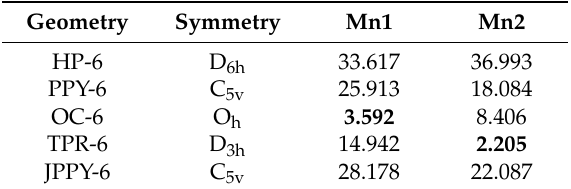
Table 2. Shape values for the five possible coordination geometries found for coordination number six in Mn1 and Mn2 in compound 1 . The minimum values are indicated in bold. Geometry Symmetry